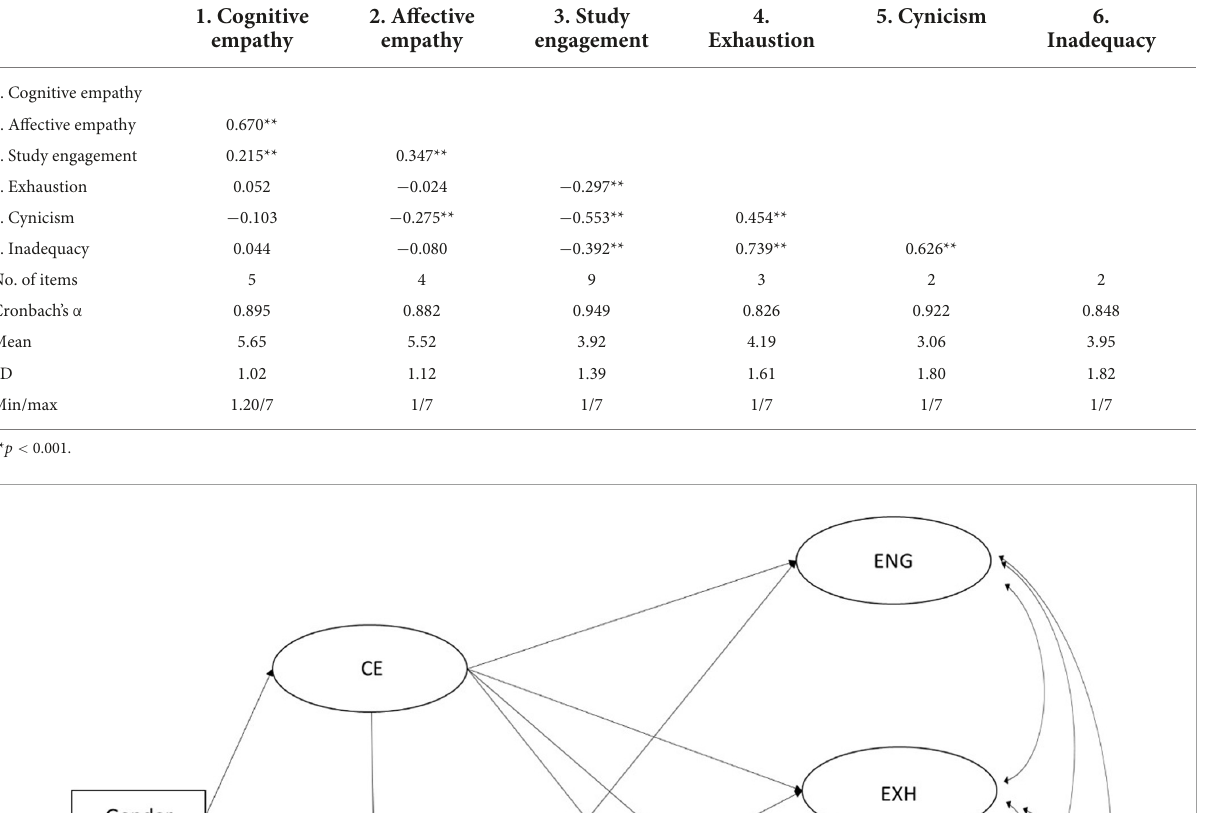
TABLE 1 The descriptive statistics of the study variables and correlations between them.